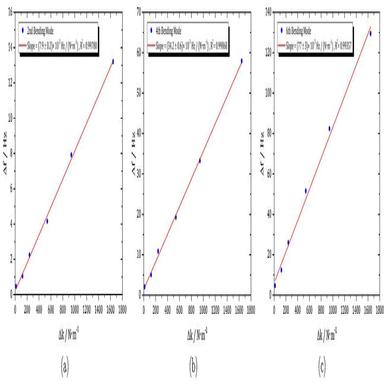
Metglas ribbons sensitivity graphs with stiffness, for the (a) 2nd, (b) 4th and (c) 6th bending modes of the cantilever beam.